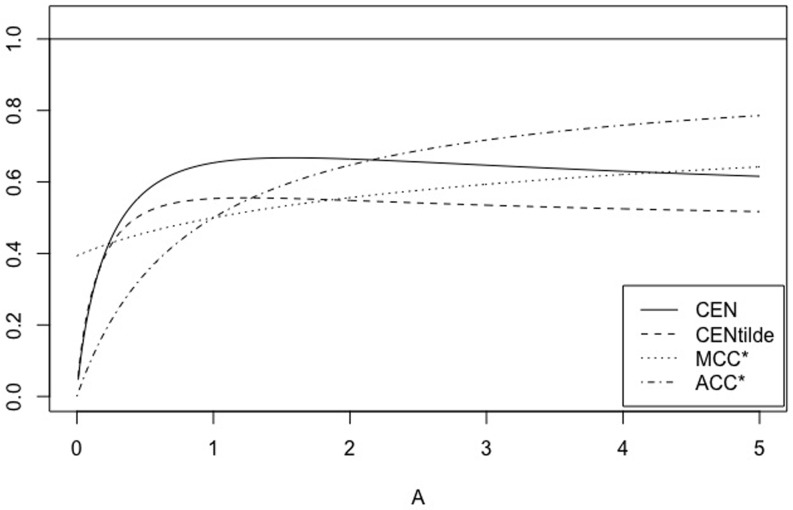
Family YA, r.CEN, MCEN, ACC* and MCC* as function of A > 0 for r = 0.1.